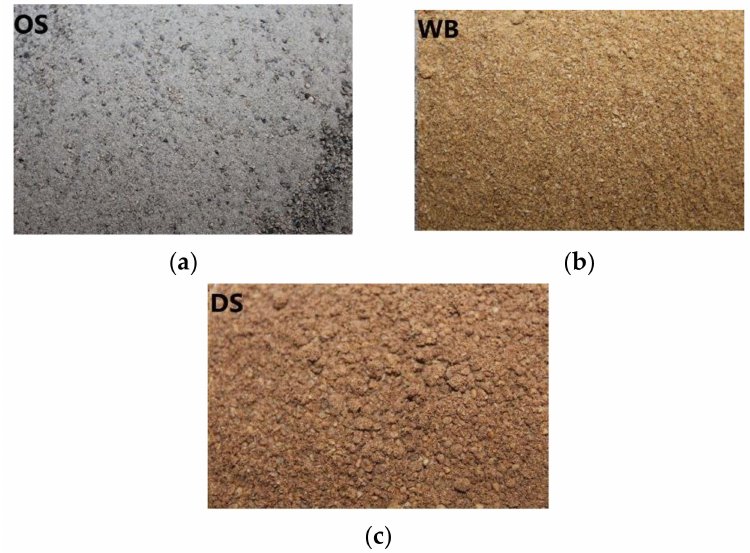
Figure 7. Macroscopic appearance of used lignocellulosic fillers: ( a ) Olive stones (OS), ( b ) wheat bran (WB), and ( c ) date seed (DS)